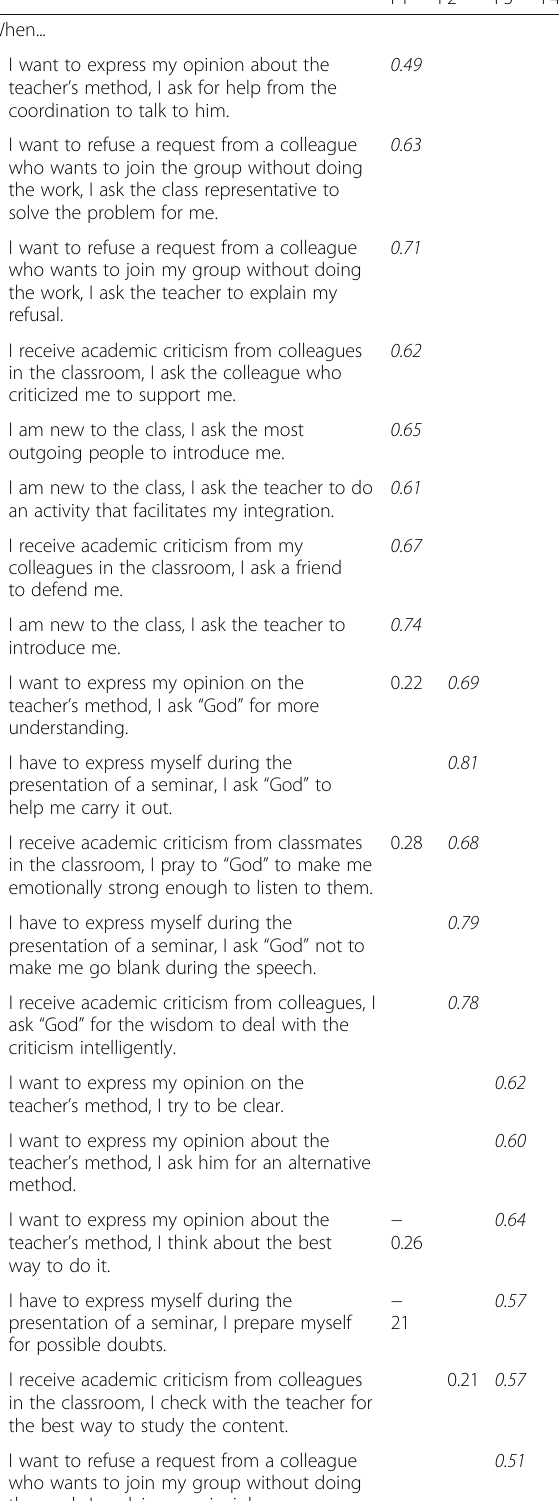
Table 4 Factor analysis (Principal Axis Factoring) relating items and factors extracted F1 F2 F3